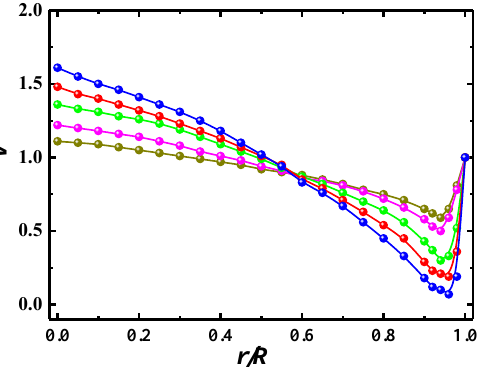
Figure 6. Distribution of particle volume concentration for different aspect ratio at outlet (Re = • : λ = 2; • : λ = 4; • : λ = 8; • : λ = 12; • : λ = 20,000, L/D = 200). ● : λ = 2; ●: λ = 4; ●: λ = 8; ●: λ = 12; ●: λ = 16. L/D = 200).